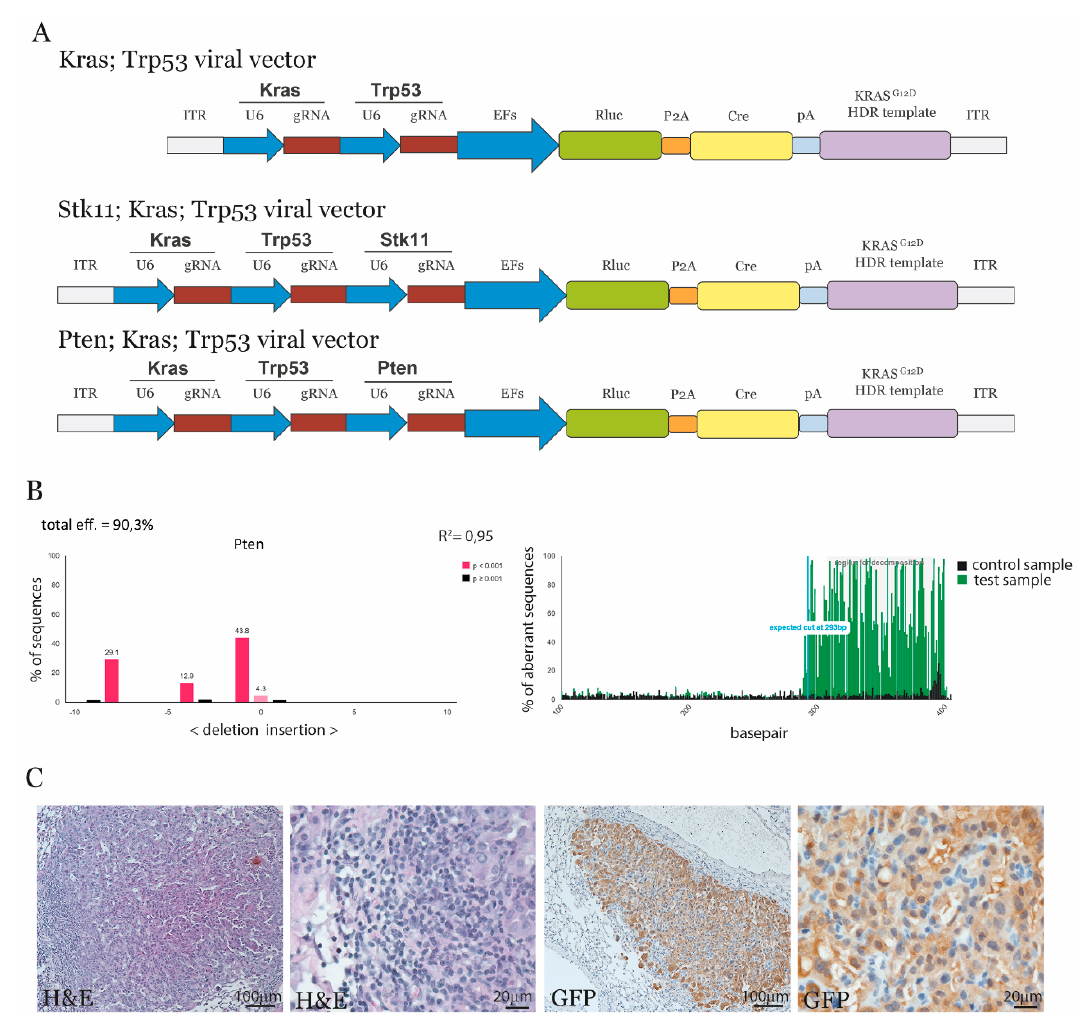
Figure 2. Induction of lung cancer by CRISPR/Cas9. ( A ) Three constructs for expression of sgRNAs and Cre by for AAV particles were generated. The first construct contains sgRNAs against Kras and Trp53 ; the second construct contains sgRNAs against Stk11 , Kras , and Trp53 ; and a third construct contains sgRNAs against Pten , Kras , and Trp53 . A U6 promoter expressed the sgRNAs, and an EF promoter expressed Cre expression. The construct also contains an 800 bp repair template for the induction of the Kras G12D mutation. ( B ) The efficiency of the Pten sgRNA was determined using the Tracking of Indels by Decomposition (TIDE) software for analysis. ( C ) Mice were inoculated with AAV particles containing the SKT viral construct, and lungs were examined 10 weeks post-treatment. Paraffin sections were stained with H&E and GFP antibody (brown stain) to confirm lung abnormalities and activation of Cas9/GFP expression in the transgenic mice ( n = 5).